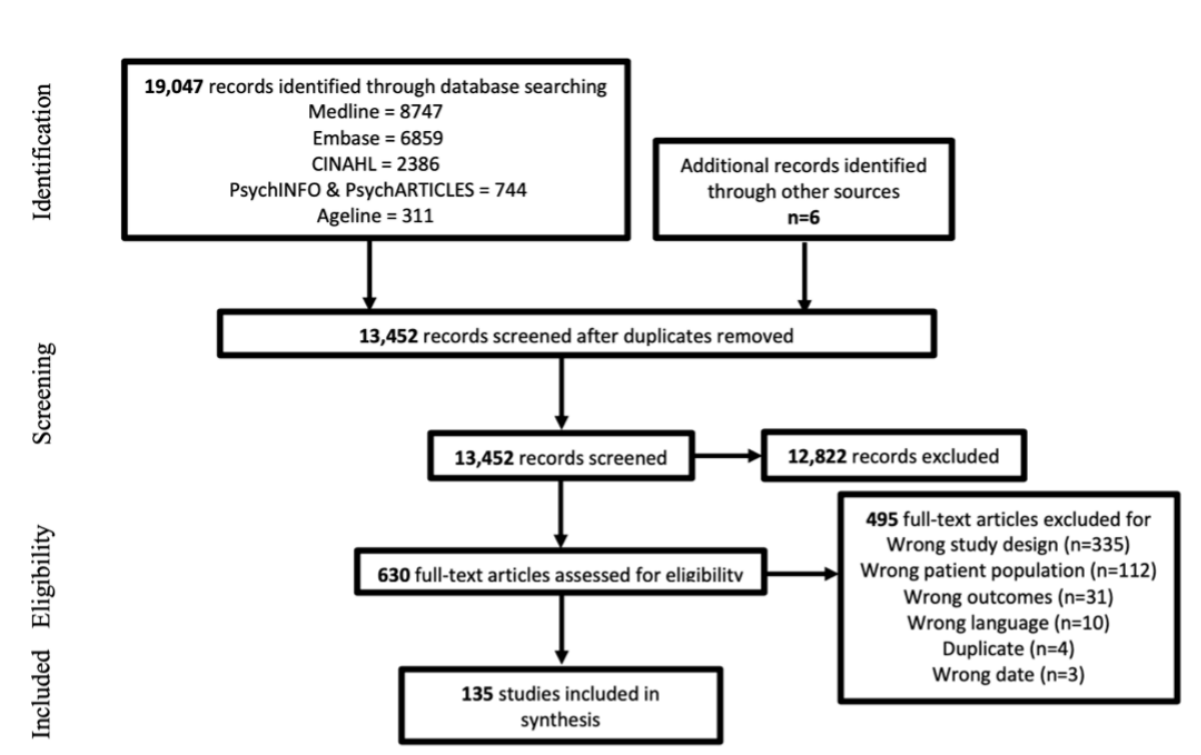
Figure 1. PRISMA (Preferred Reporting Items for Systematic Reviews and Meta-analyses) flow